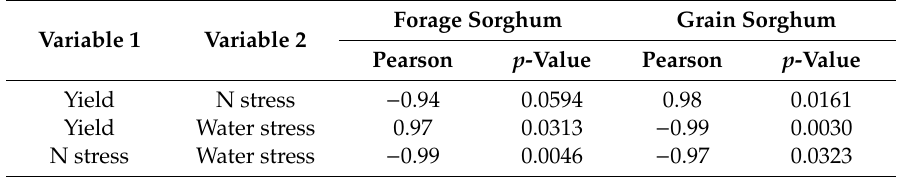
Table 6. Degree of correlation (Pearson coefficient, r ) between simulated yields and the simulated days of N and water stress, and between both types of stresses.